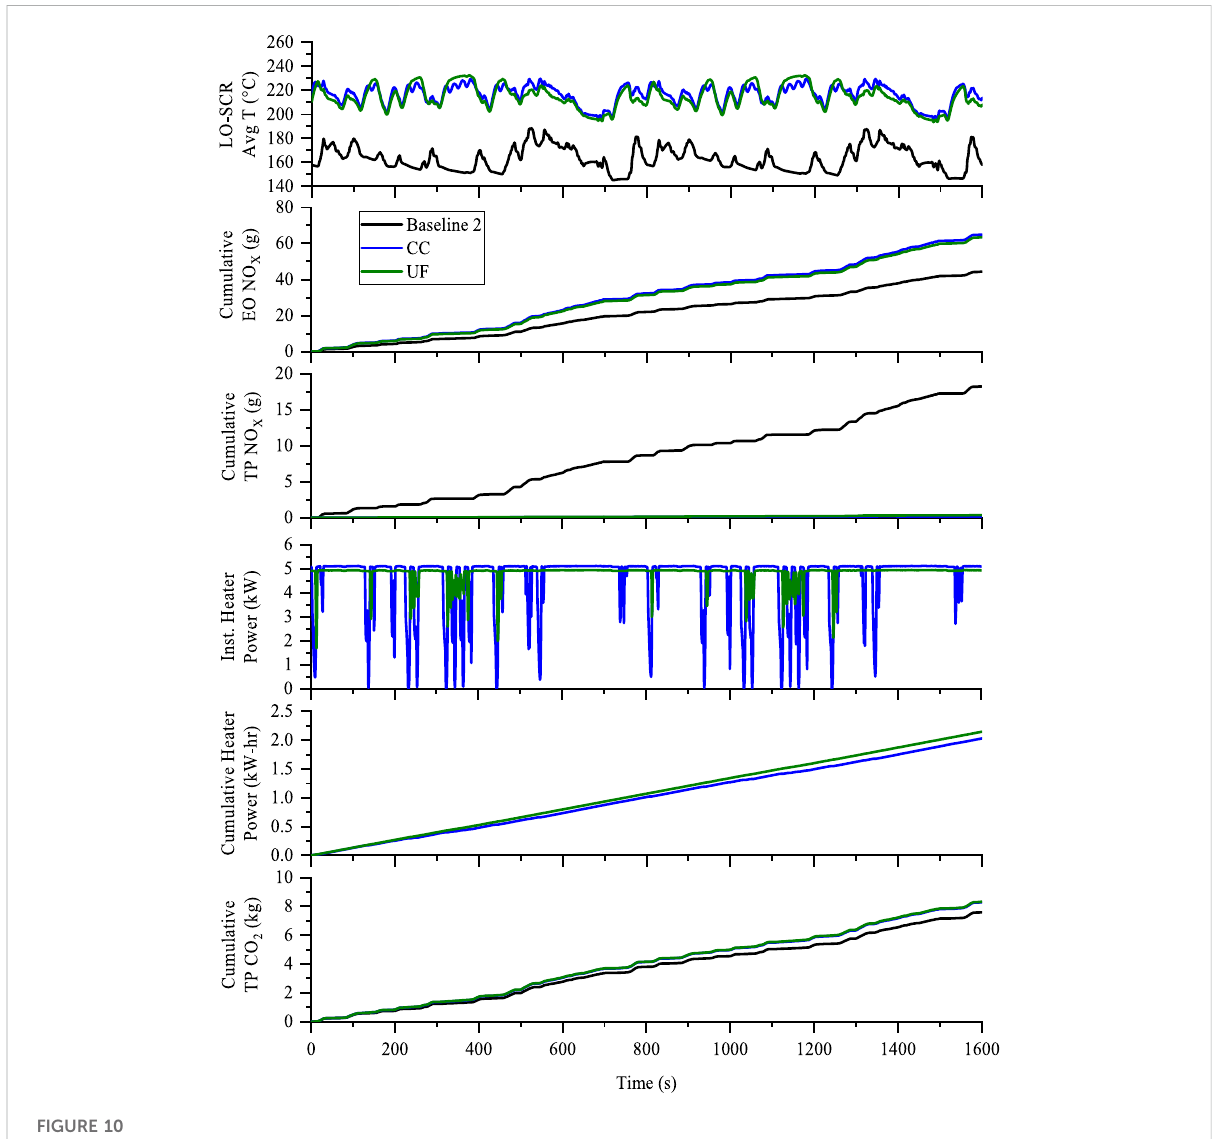
FIGURE 10 ComparisonoftheCCLO-SCRandUFLO-SCRtoBaseline2ontheBeveragecyclefortheLO-SCRaveragetemperature,emissions,andheater electrical power consumption.